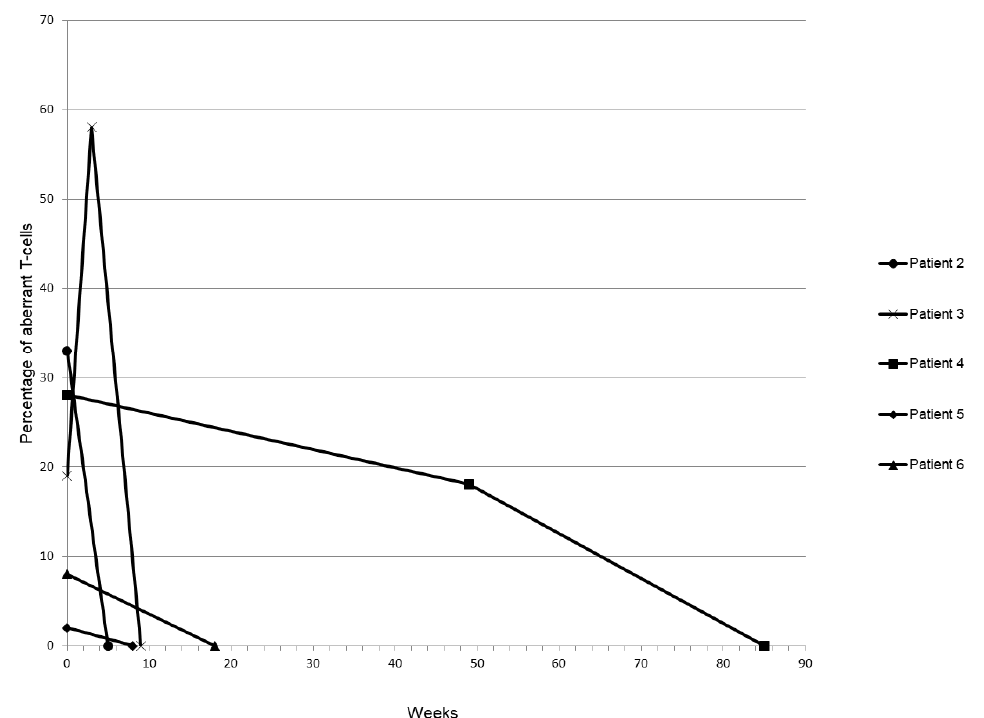
Figure 4. Time-course of aberrant T-cell clearance. The percentage of SSC/FSC-low aberrant T-cells per total lymphocyte count was determined throughout a follow-up period of several weeks in